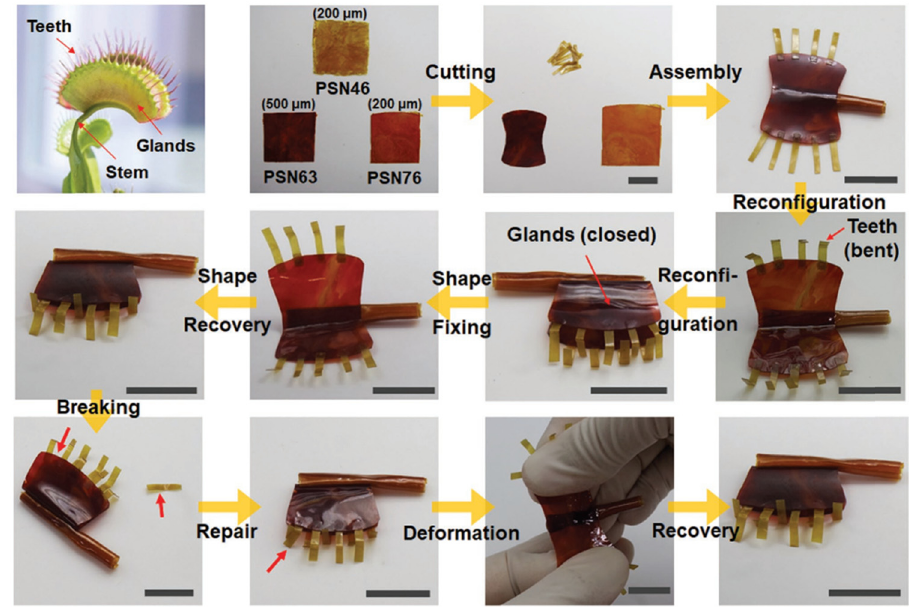
Figure 4: Demonstration of photocontrolled assembly, recon fi guration, shape fi xing/recovery, and repair of PSN - based 3D multishape memory structures, mimicking the constitution and motion of Venus fl ytrap ( scale bar = 2 cm ) . Copyright 2020, John Wiley & Sons – Books ( 75 )